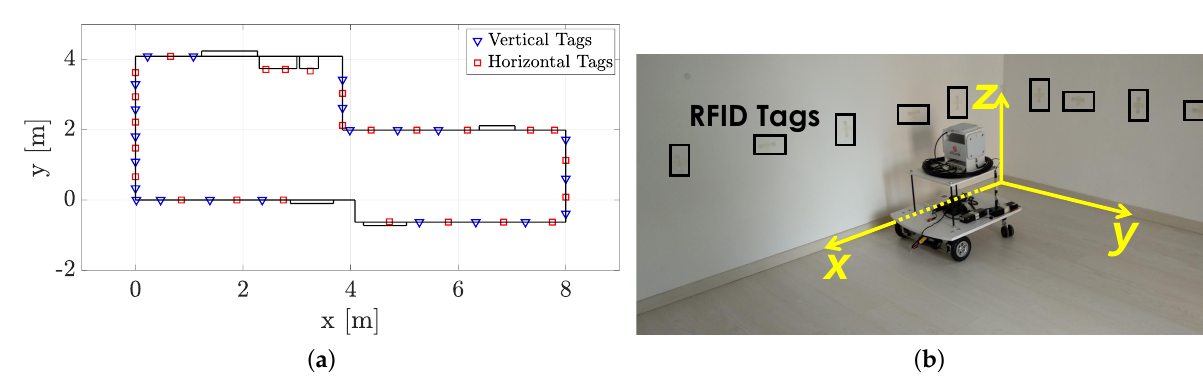
Figure 3. Experimental setup. ( a ) Room map, with the two areas. Vertical tags are depicted as blue triangular markers, Horizontal tags are depicted as red square markers. ( b ) A picture of the robot taken during the experimental campaign.